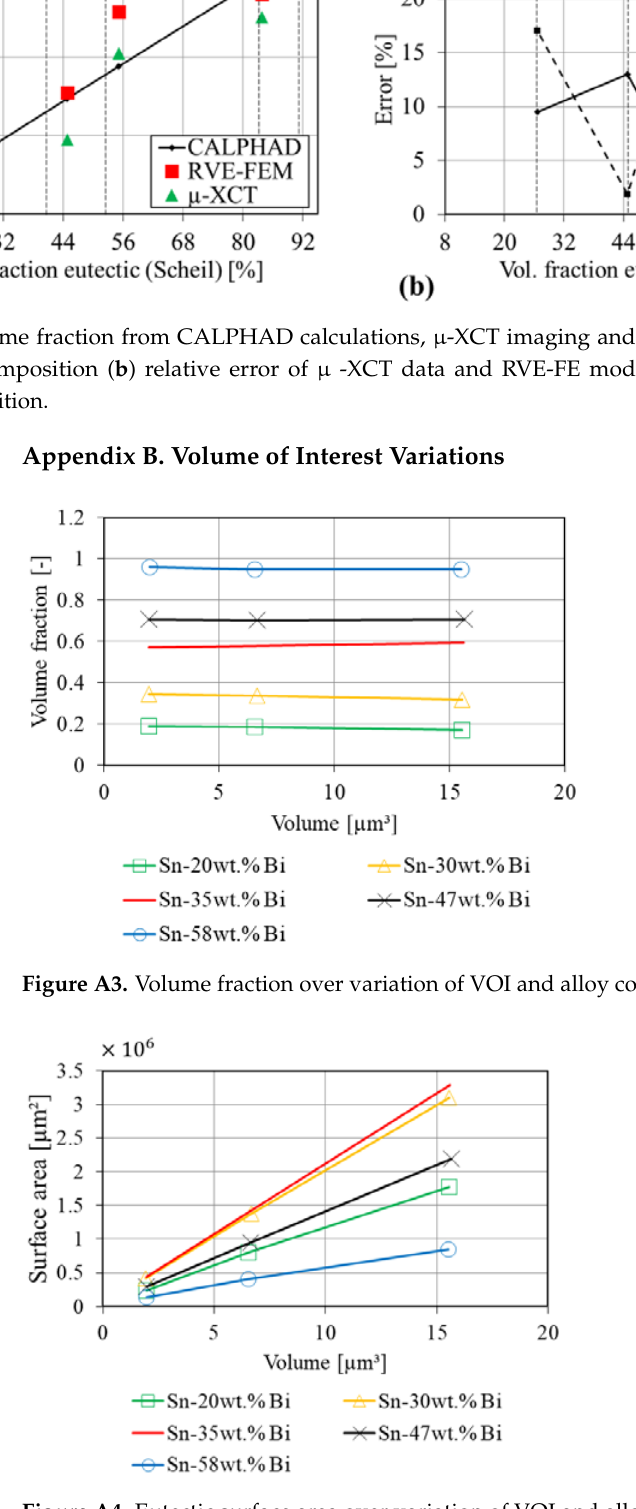
Figure A4. Eutectic surface area over variation of VOI and alloy Figure A4.